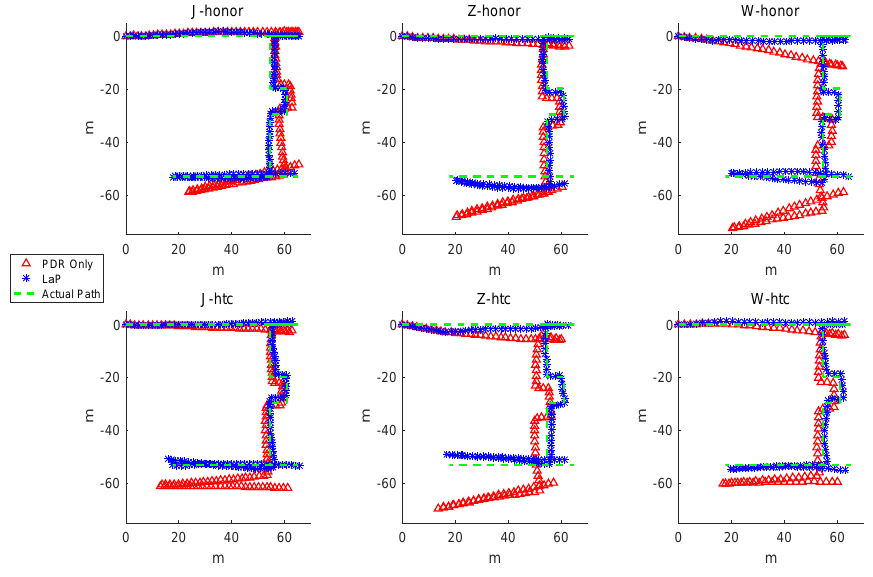
Figure 11. The actual path, the trajectories of PDR and